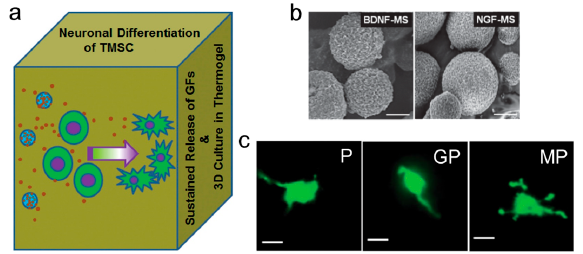
Figure 6. ( a ) PEG-L-PA thermogel as a 3D cell culture matrix incorporating TMSCs and neuronal growth factor loaded microspheres; ( b ) NGF-loaded and BDNF-loaded alginate microspheres. Scale bar is 1 µ m; ( c ) Image of cells cultured in PEG-L-PA thermogel with different growth factors: P indicates